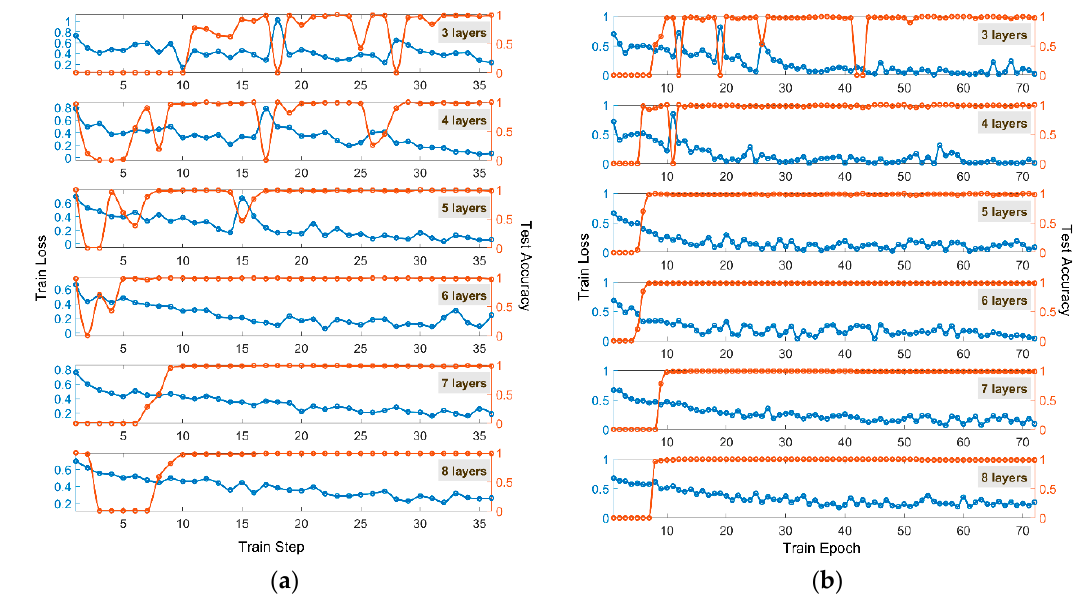
Figure 5. Optical neural network classification performance based on the time-lens. The orange line represents training accuracy, and the blue one is training loss. ( a ) Training result of a series of TL-ONN composed of 3–8 time lens layers. ( b ) Training result of TL-ONN after exchange of two phase modulators consisting of 3–8 time lens layers.